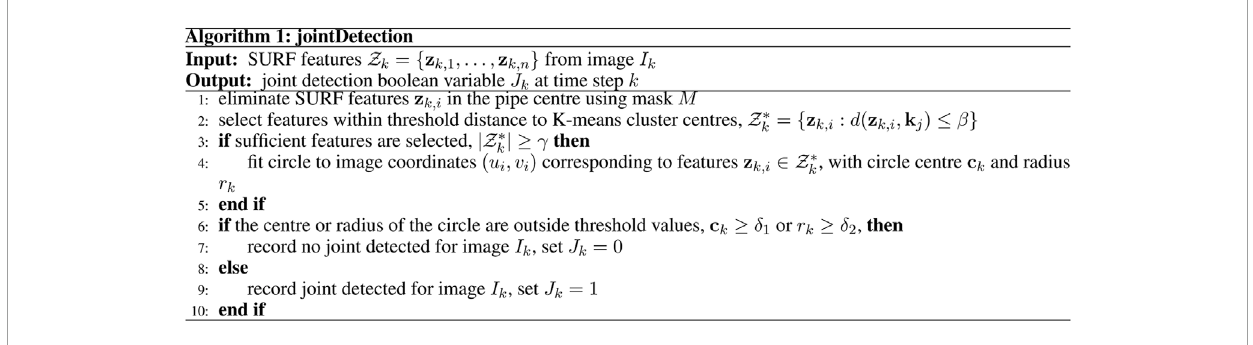
FIGURE 4 Algorithm 1: Joint detection in a single image